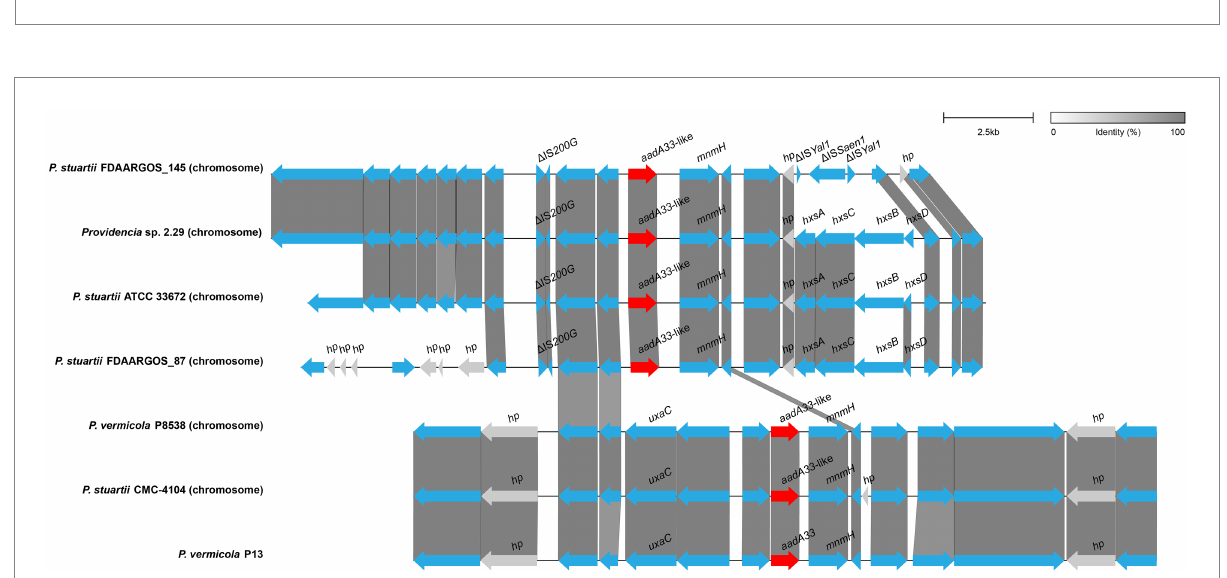
FIGURE 5 Genetic environment of the aadA33 and aadA33 -like genes. Regions with ≥ 80% amino acid identity were colored grey. Accession numbers: Providencia stuartii FDAARGOS_145 (NZ_CP014024.2), Providencia sp. 2.29 (NZ_CP065420.1), P. stuartii ATCC 33672 (NZ_CP008920.1), P. stuartii FDAARGOS_87 (NZ_CP031508.1), P. vermicola P8538 (NZ_CP048796.1) and P. stuartii CMC-4104 (CP095443.1). hp : hypothetical